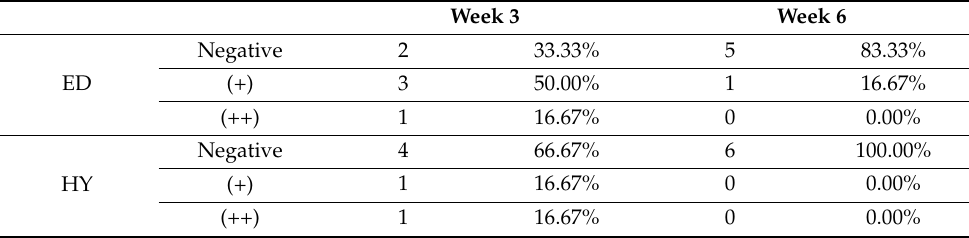
Table 1. Inflammation scores in 3rd and 6th weeks. A chi-square test was